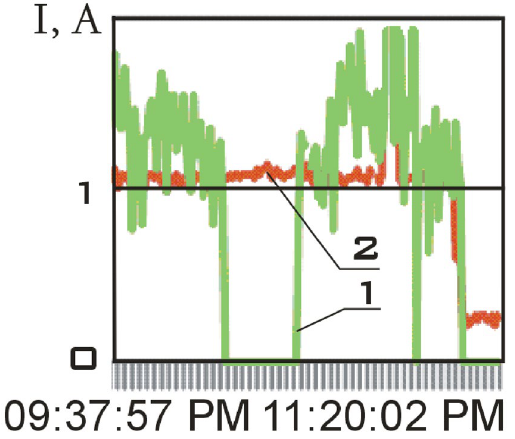
Figure 4. There is dynamics of currents in the power supply system of the small spacecraft prototype "Aist" according to telemetry data from 03/25/2014: 1 is battery charging current; 2 is current of power consumption of scientific